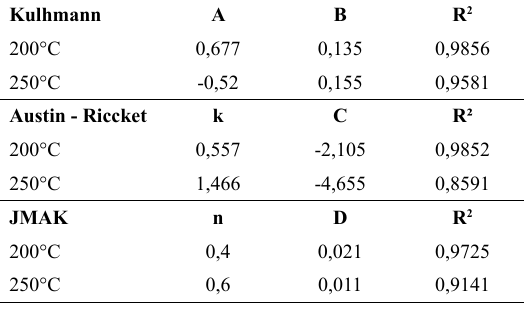
Figure 12. JMAK’s exponential and linear data fitting of isothermal annealings at 200°C and 250°C. Table 3. Summarized results of all models used to adjust the experimental data